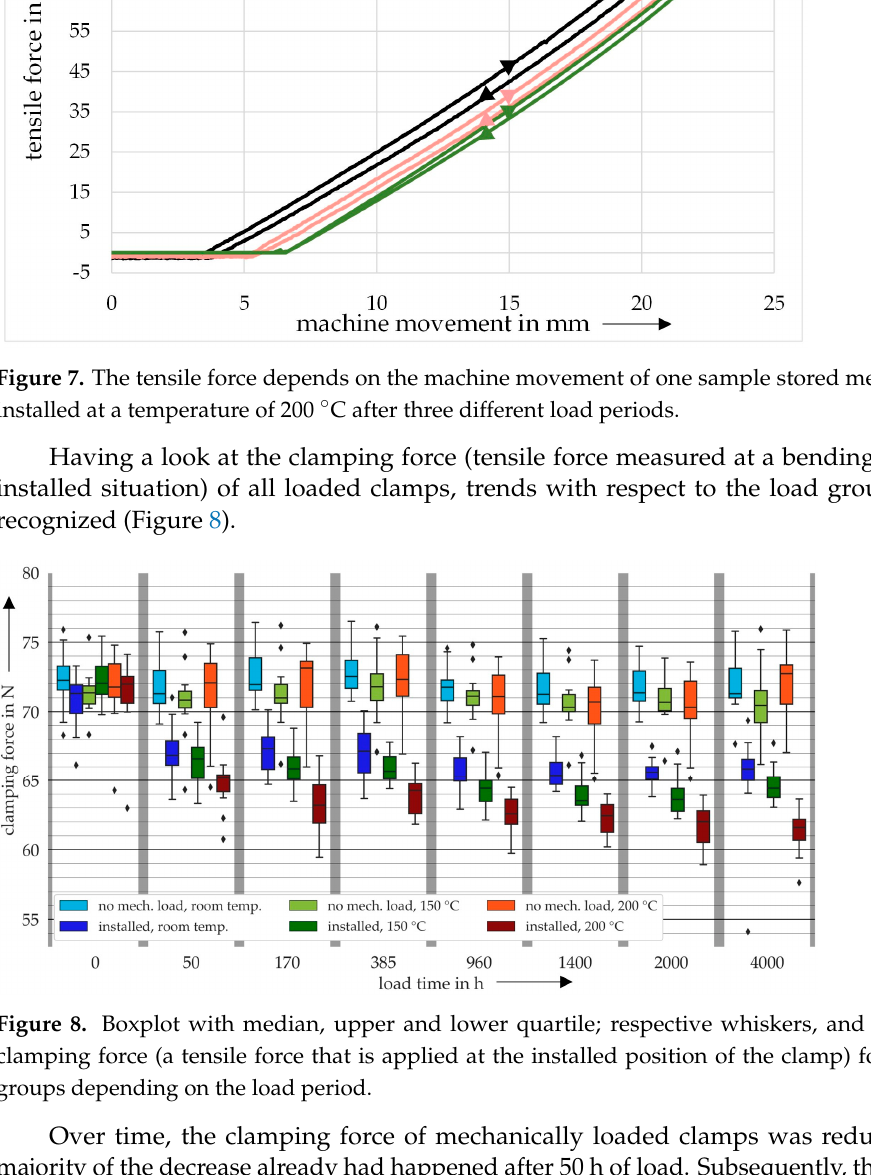
Figure 8. Boxplot with median, upper and lower quartile; respective whiskers, and outliers of clamping force (a tensile force that is applied at the installed position of the clamp) for the load groups depending on the load period.